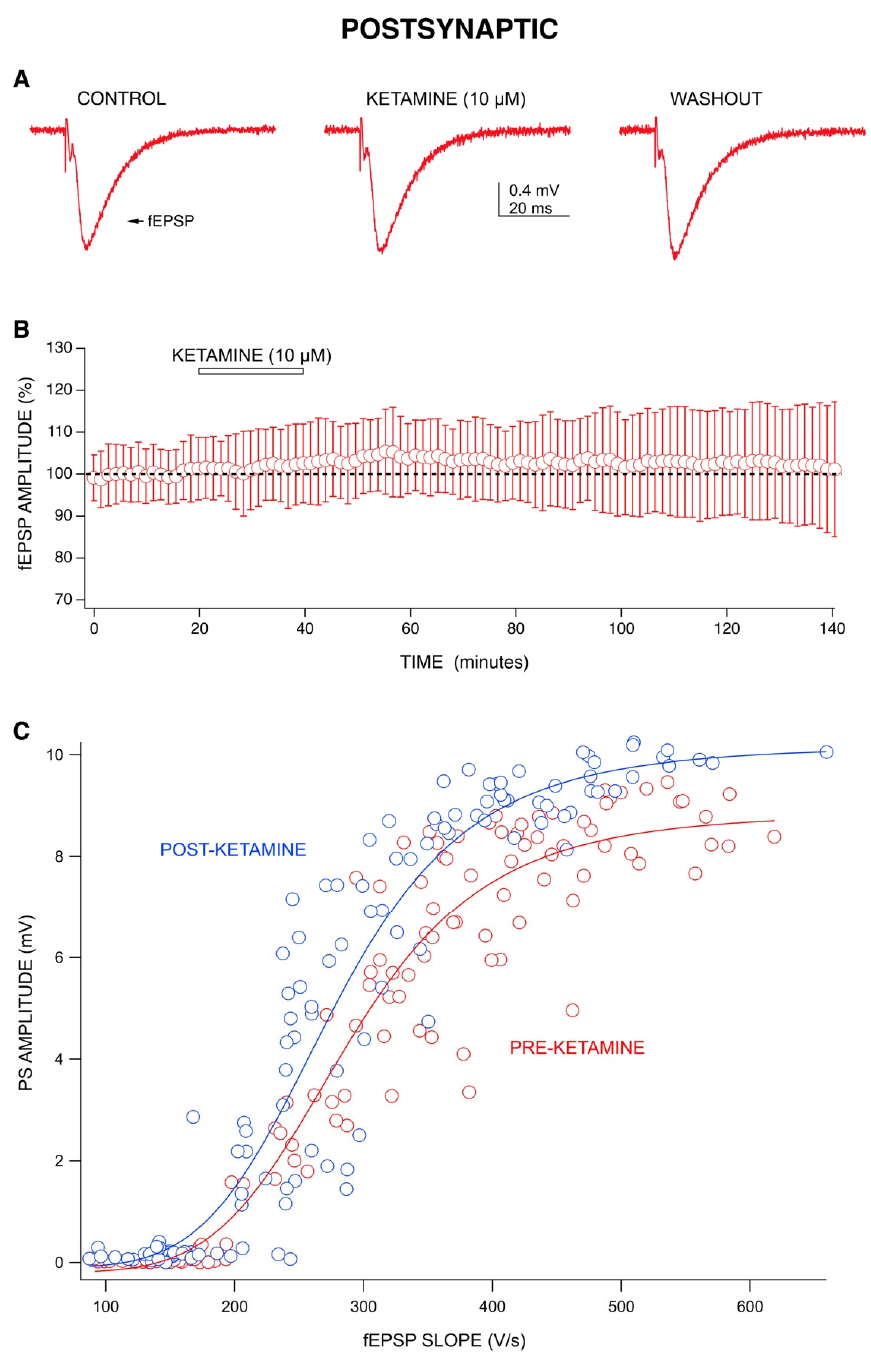
Figure 3. Evaluating the mechanisms behind ketamine’s effects: Postsynaptic actions. ( A ) Representative recordings from one ketamine experiment (10 µ M) showing little change in fEPSP amplitudes during application and washout. ( B ) Combined graph ( n = 9) shows ketamine (10 µ M) did not have an effect on fEPSP amplitudes. Each data point represents the mean ± standard deviation derived from a data set of nine averaged experiments decimated from approximately 420 to 100 data points. ( C ) The relation of fEPSP slopes to PS amplitudes, with increasing stimulus intensities, revealed that a steeper slope was observed for post-ketamine responses. A quantity of 10 µ M ketamine increased the amplitudes of PSs but not the slopes of fEPSPs. Data were fit to a Hill equation using Igor Pro. To determine whether ketamine increased CA1 neuron excitability rather than synaptic strength, we compared the amplitude of PSs to the slope of fEPSPs before and after